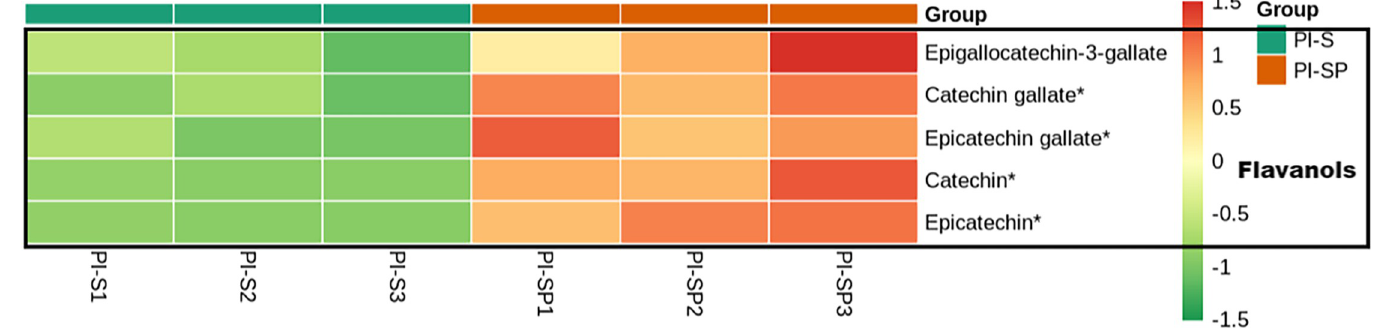
PLOS ONE | https://doi.org/10.1371/journal.pone.0274013 September 2,